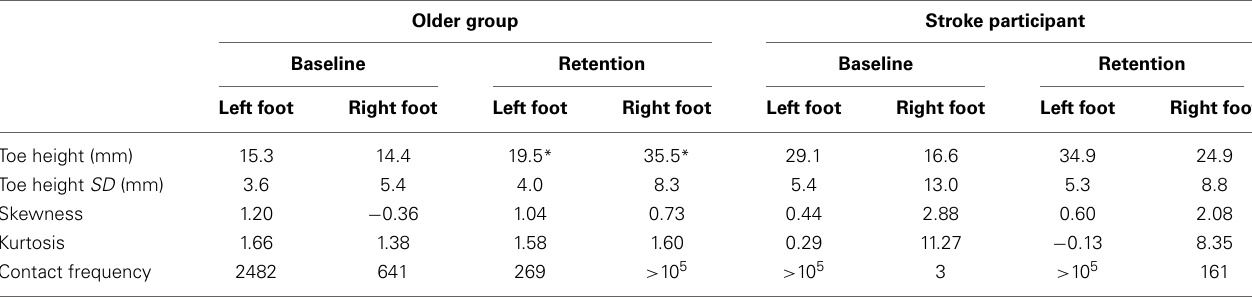
Table 2 | Toe height characteristics at the Minimum Toe Clearance (MTC) swing-phase event.